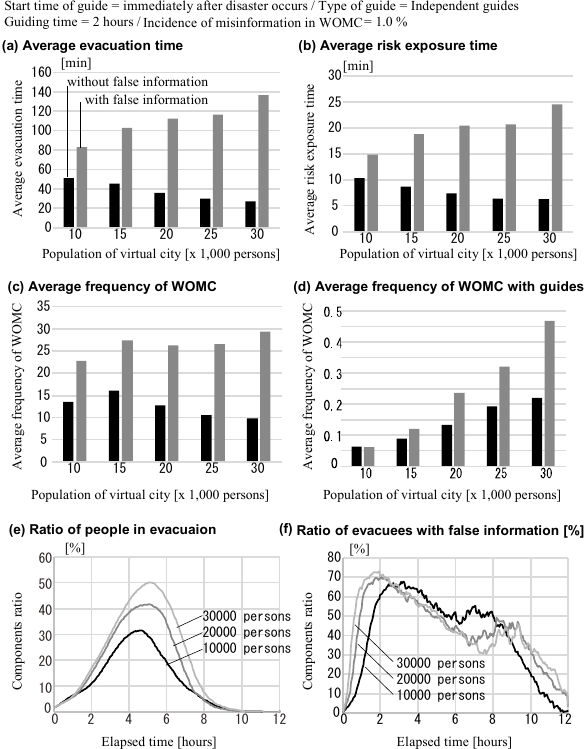
Figure 18. Influence of population density on dissemination of disaster information As long as no false information appears in a city with a high population density, it is easy for accurate information to be disseminated. The evacuation time will then be short and the risk will be low (Figures 18(a) and (b)). Once false information has appeared and spread by WOMC, however, it becomes very difficult to accomplish a rapid and safe evacuation, and the evacuation time and risk increase (Figures 18(a) and (b)). This is due to the following factors. When the population density is high, there are more people evacuating at the same time (Figure 18(e)); this increases the frequency with which evacuees meet each other, and accordingly, the frequency of their WOMC (Figure 18(c)). They also run into guides who provide